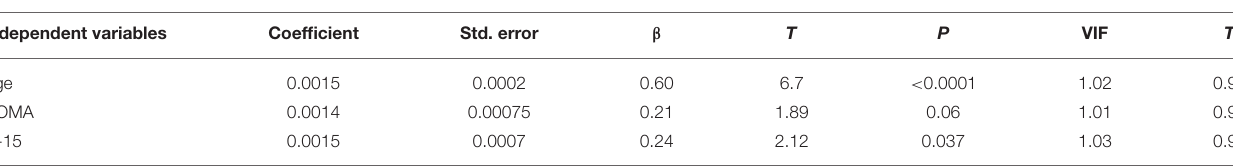
TABLE 3 | Prediction of IMT by IL-15 and other CAD risk factors. Independent variables